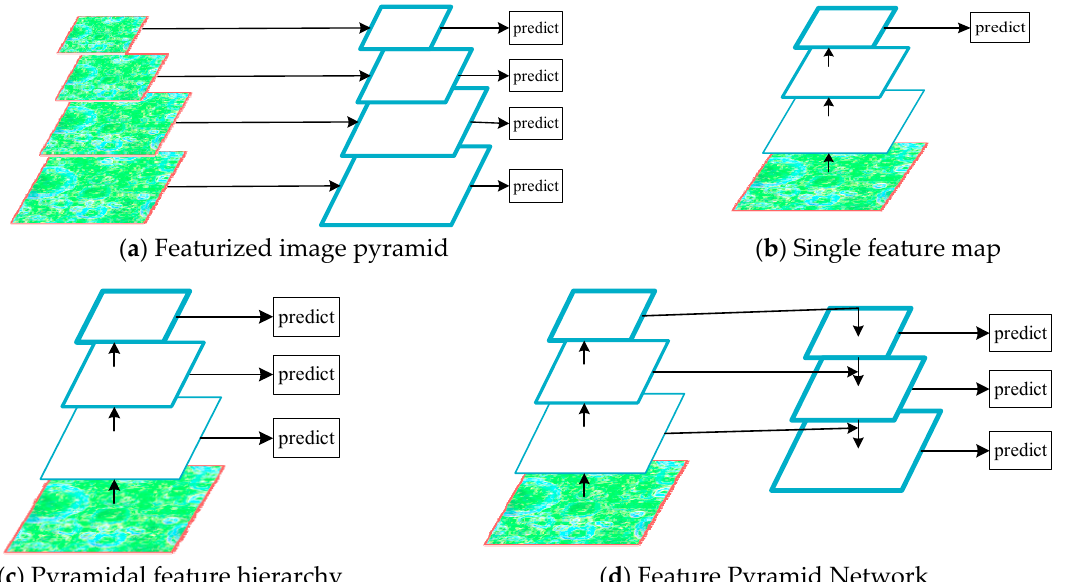
Figure 4. The multi-scale detection methods.